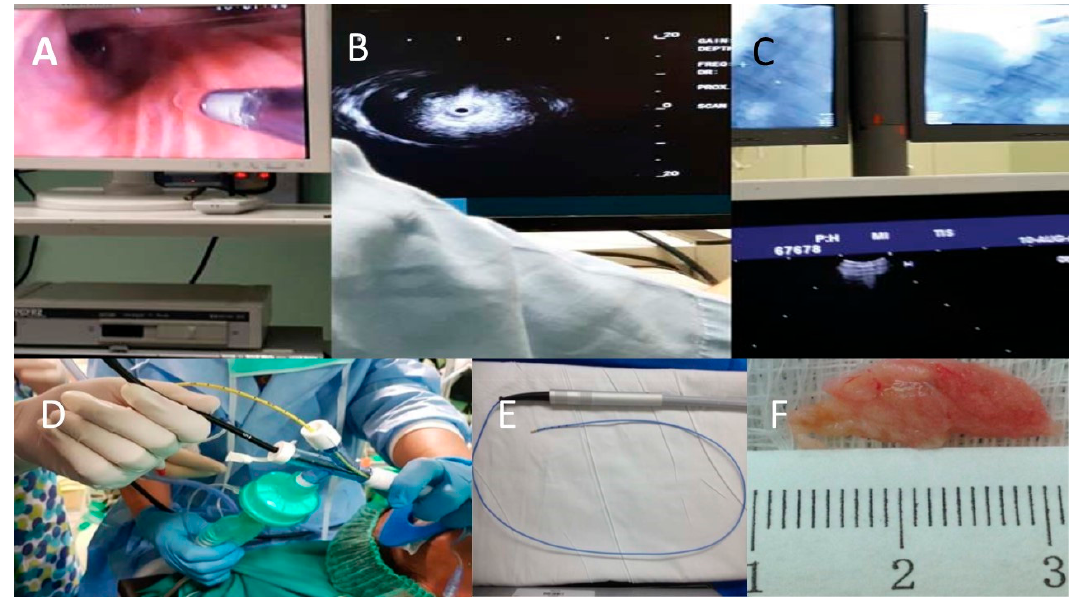
Figure 1. ( A ): radial-ebus probe endobronchially; ( B ): radial-ebus probe ultrasound image; ( C ): Figure 1. fluoroscopy. ( D ): patient intubated with double lumen endotracheal tube with inlet for the endo- scope and fogarty balloon; ( E ): ERBE cryoprobe; ( F ): lung parenchyma tissue sample.